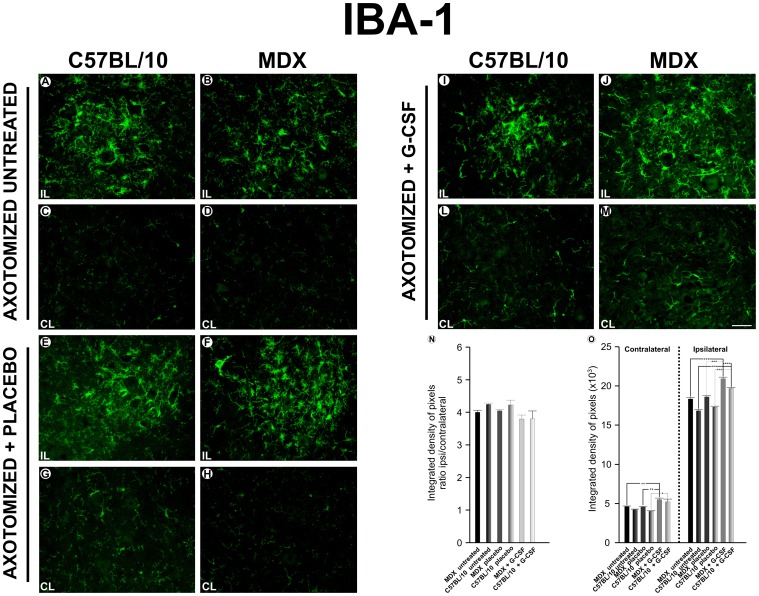
Anti-IBA1 immunostaining one week after axotomy.
A and C, the ipsilateral (IL) and contralateral ventral column of the spinal cord of the C57BL/10 strain seven days after axotomy; B and D, the ipsilateral and contralateral ventral column of the spinal cord of the MDX seven days after axotomy; E and G, the ipsilateral and contralateral of the C57BL/10ipsilateral+ placebo group seven days after the axotomy; F and H, the ipsilateral and contralateral of the MDX ipsilateral+ placebo group; I and L, the ipsilateral and contralateral of the C57BL/10 ipsilateral+ G-CSF group; J and M, the ipsilateral and contra lateral of the MDX ipsilateral+ G-CSF group. In all experiments: n = 5. In A–M, magnification, X200 (scale bar, 50 µm).The alpha-motoneurons were quantified in 3 distinct fields along the lumbar intumescence. In N, *p<0.05, **p<0.01, ***p<0.001 vs. CT, values are means ± SEM.